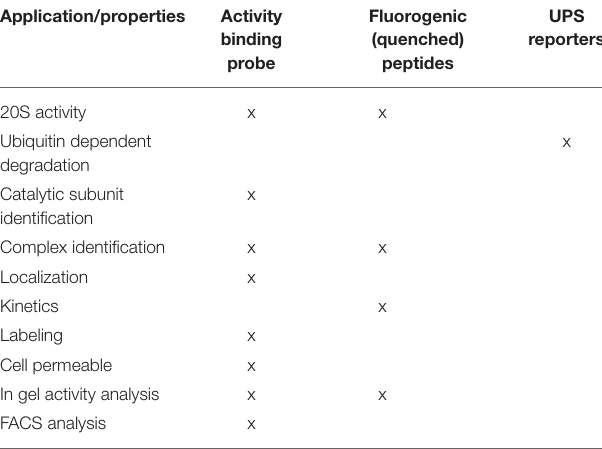
TABLE 1 | Overview of fluorescent activity